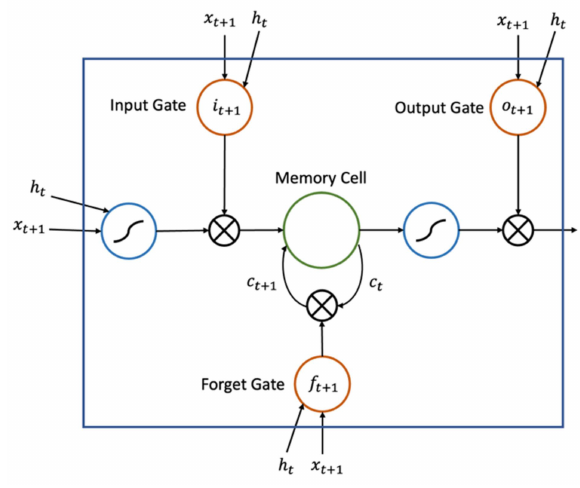
Figure 11. Long short-term memory training unit.